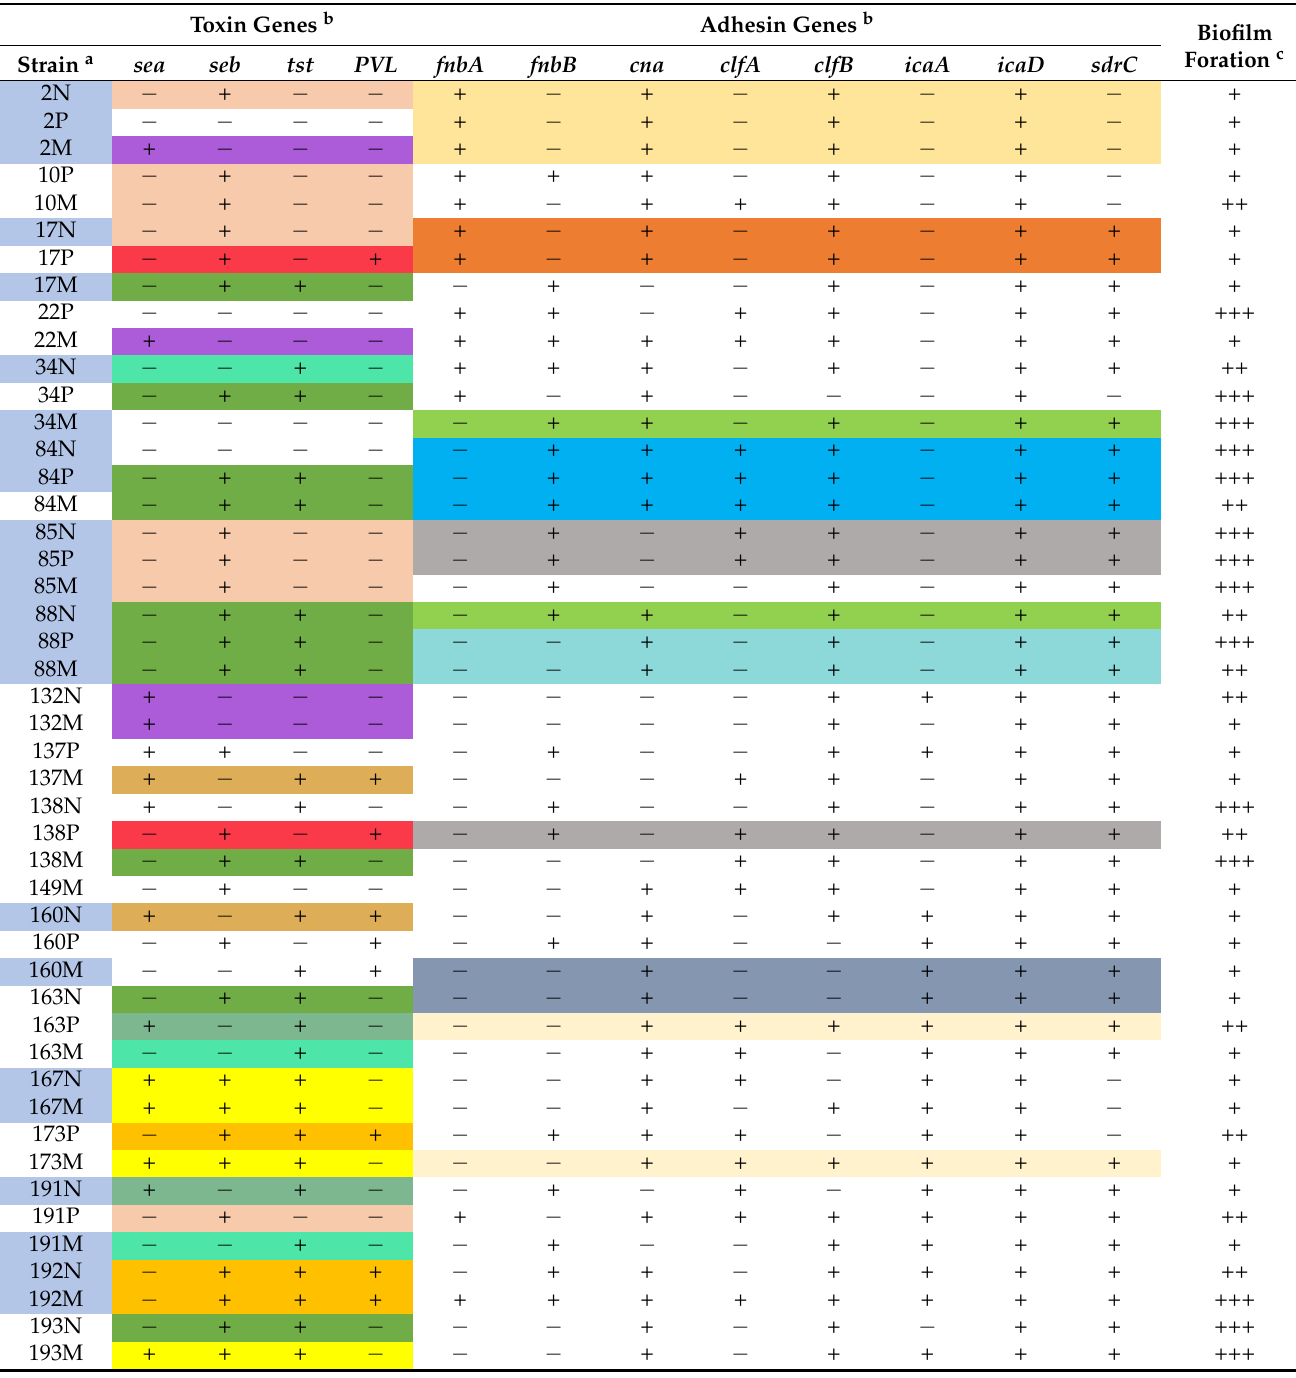
Table 2. Toxin genes, adhesin genes, and biofilm formation detected in Staphylococcus aureus strains isolated from students and their mobile